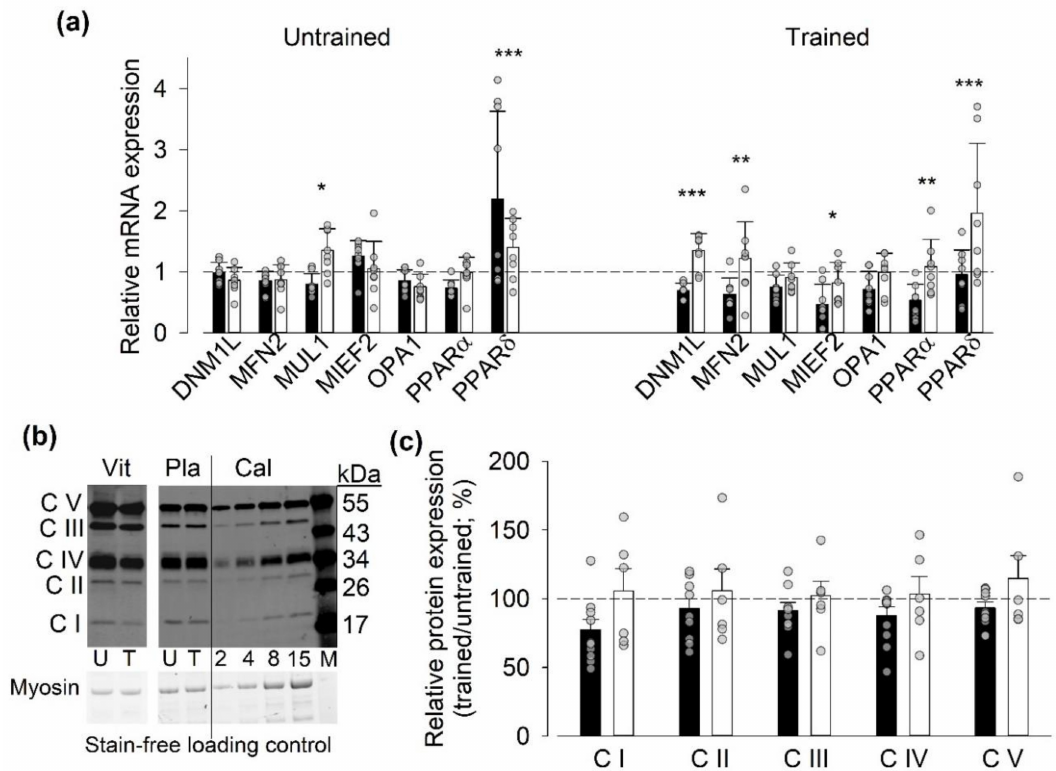
Figure 5. Vitamin-treatment-blunted SIT-induced changes in mRNA expression of genes encoding for mitochondria-related proteins in the trained state. ( a ) Mean and individual data of the ratio of mRNA expression 1 h after to that before the first (Untrained) and last (Trained) SIT sessions in individuals treated with vitamins ( n = 9) or with placebo ( n = 7); dashed line indicates no di ff erence between before and after exercise. Two-way repeated measures ANOVA showed a general group di ff erence ( p < 0.01) in the trained state. Di ff erence between vitamin and placebo groups in relative mRNA expression of individual genes: * p < 0.05, ** p < 0.01, *** p < 0.001. ( b ) Representative original Western blots of mitochondrial complex I–V components (CI-CV) in muscle biopsies from one vitamin (Vit) and one placebo-treated (Pla) individual. Biopsies taken before the first (untrained, U) and the last (trained, T) SIT sessions. Calibration (Cal) shows loading of 2, 4, 8, and 15 µ L, which represent 5, 10, 20, and 37.5 µ g muscle wet weight. Lane labeled M shows protein size ladder. ( c ) Mean and individual data of the relative protein expression in biopsies obtained in the untrained and trained state in individuals treated with vitamins ( n = 9-10) or with placebo ( n = 6). Data expressed as the ratio of the expression in the trained to that in the untrained state. No significant di ff erences between the untrained and trained state or between vitamin- and placebo-treated participants were observed with two-way repeated measures ANOVA. Data are shown as mean ± SD; vitamin group, black bars; placebo group, white